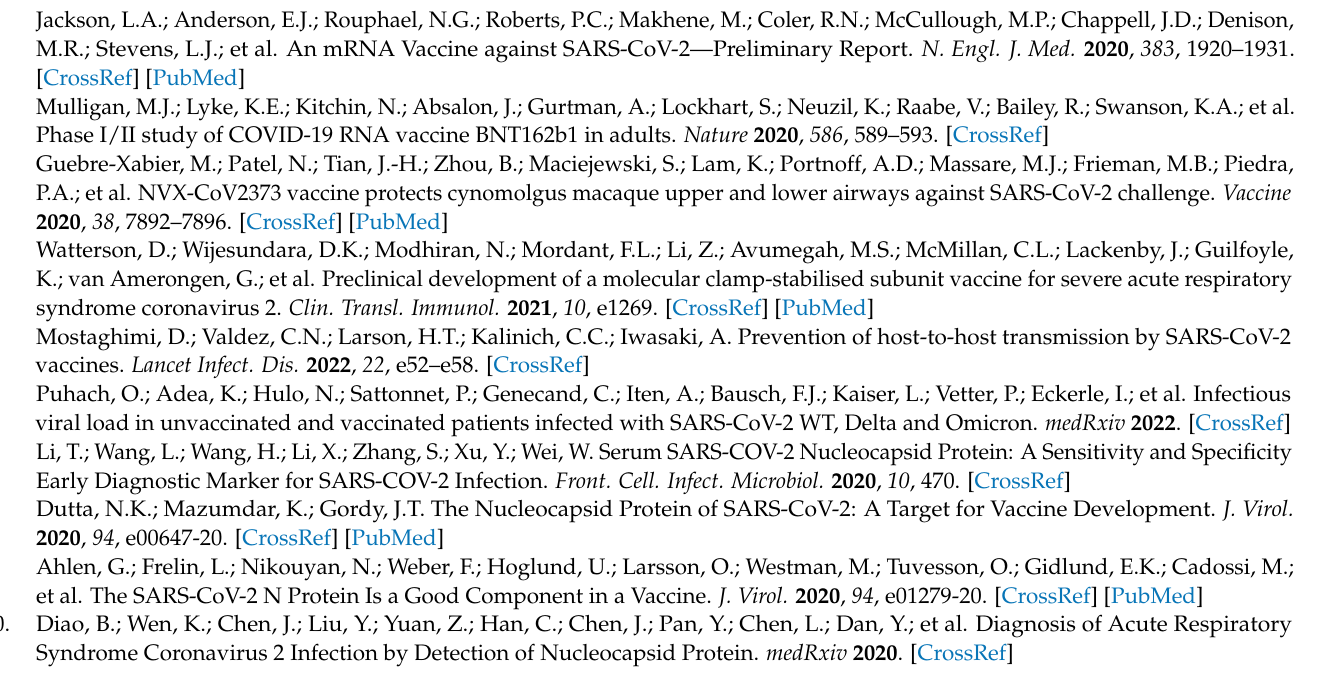
serum, Figure S3: Multiple immunofluorescence labelling confirmed the lack of adverse effects on the density and morphology of neurons and microglia in the hippocampus of immunized mouse brain, Figure S4: Multiple immunofluorescence labelling confirms the lack of inflammation in immunized mouse brain, Table S1: Antibodies and their use for biochemistry and histochemistry, Table S2: Gene expression in spleen measured by qPCR, List of material and reagents